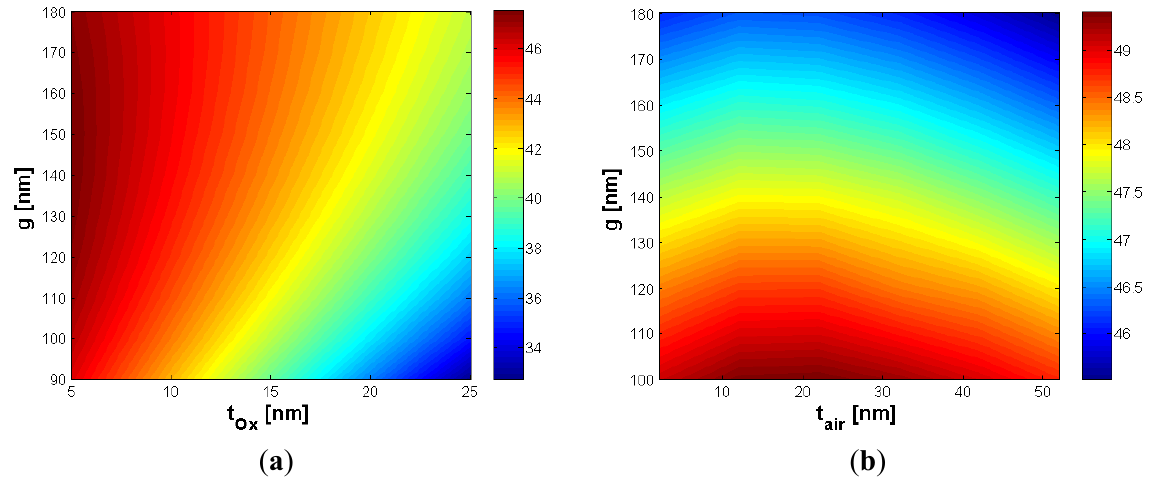
(%) versus t and g , with H = 220 nm and W = 210 nm; ( b ) Γ Figure 4. ( a ) Γ c ox and g , with H = 220 nm and W = 210 nm. t air